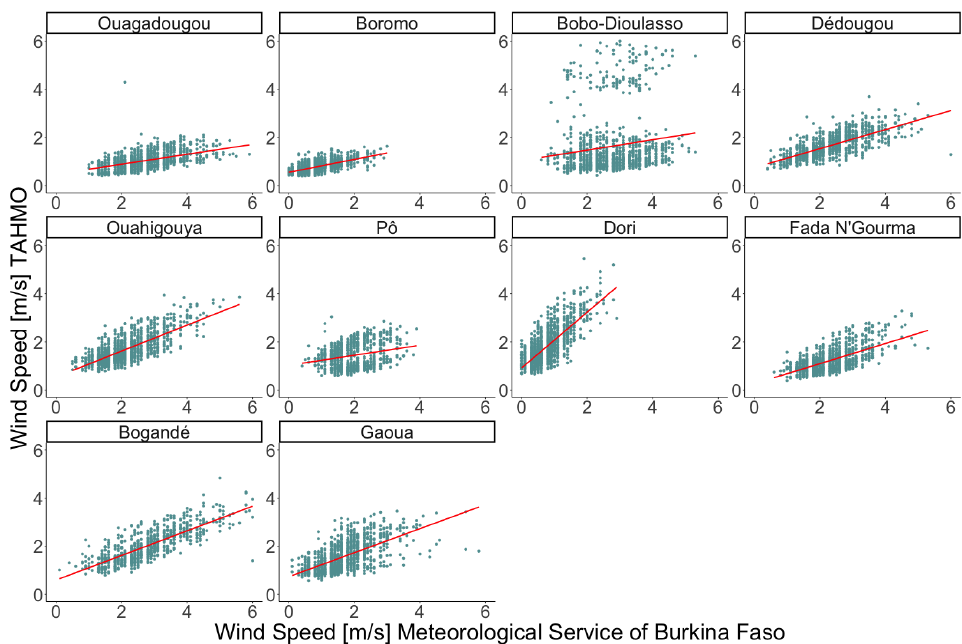
Figure 17. Scatterplot between wind speed time series of TAHMO stations ( y -axis) and the corre- sponding stations from meteorological service of Burkina Faso ( x